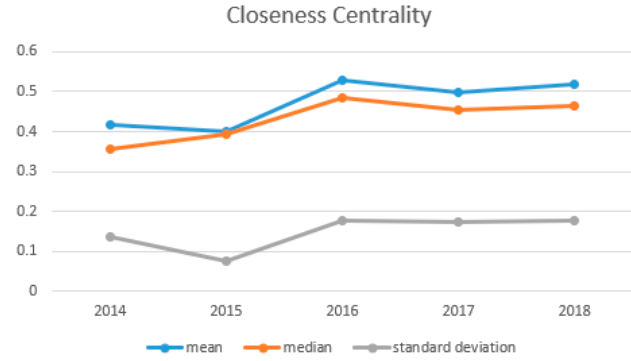
Figure 7. The statistical indicators of closeness centrality curve during